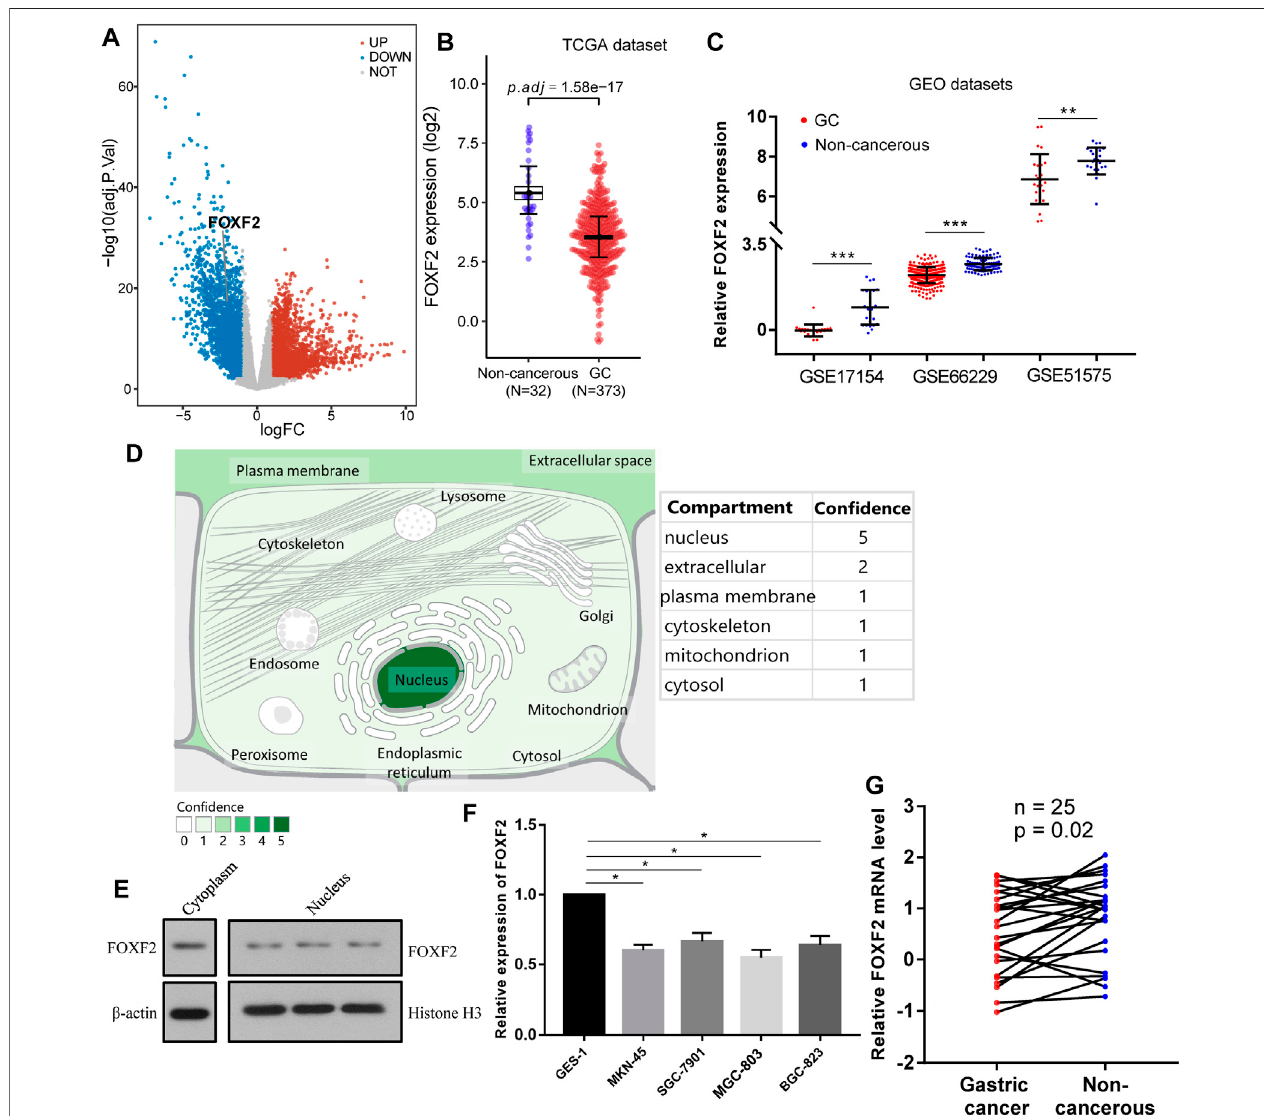
FIGURE 1 | FOXF2 was downregulated in GC cells and tissues. (A) A total of 5,588 differentially expressed genes (2,878 highly and 2,710 low expressed genes) were identi fi ed by analyzing GC RNA-Seq data from the TCGA dataset. (B) According to the TCGA dataset, FOXF2 was signi fi cantly downregulated in 373 GC tissues. (C) Three expression pro fi ling data from GEO datasets showed that FOXF2 was down-regulated in GC tissues. (D) The subcellular location prediction from COMPARTMENTS showed that FOXF2 has the greatest possibility of mainly being located in the nucleus, cytoplasm and extracellular. (E) The cytoplasm and nucleus protein separation assay found that FOXF2 protein was both detected in cytoplasm and nucleus. (F,G) The qRT-PCR assay indicated that FOXF2 was signi fi cantly downregulated in GC cells and tissues. * p < 0.05, ** p < 0.01, and *** p <